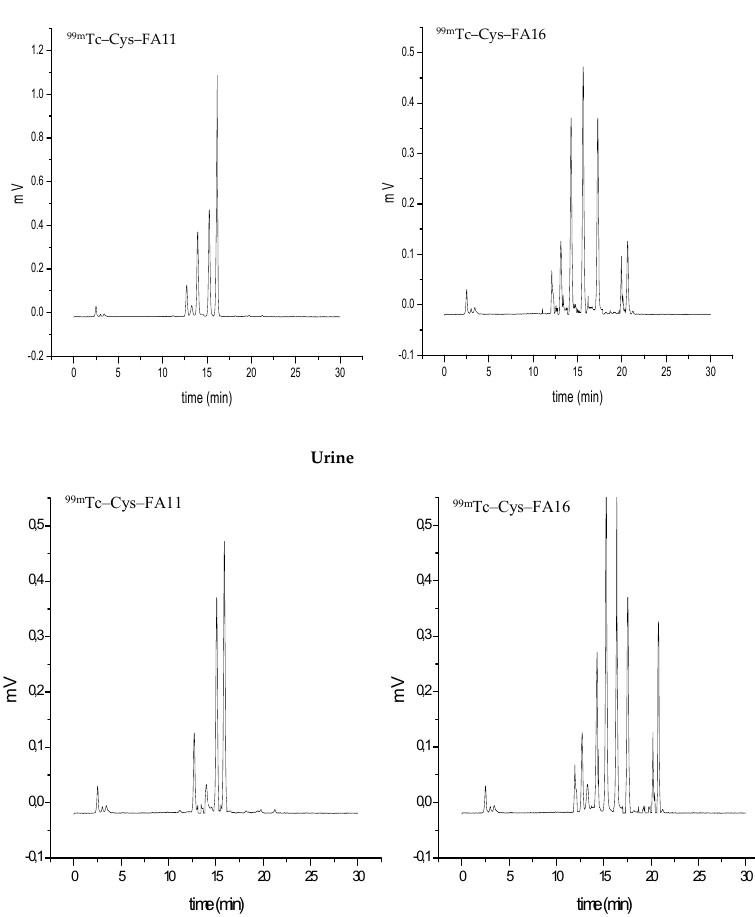
Figure 3. Reverse phase HPLC chromatograms ( γ -detection) of liver homogenates and urine analysis 15 min after injection of 99m Tc–Cys–FA11 and 99m Tc–Cys–FA16 in